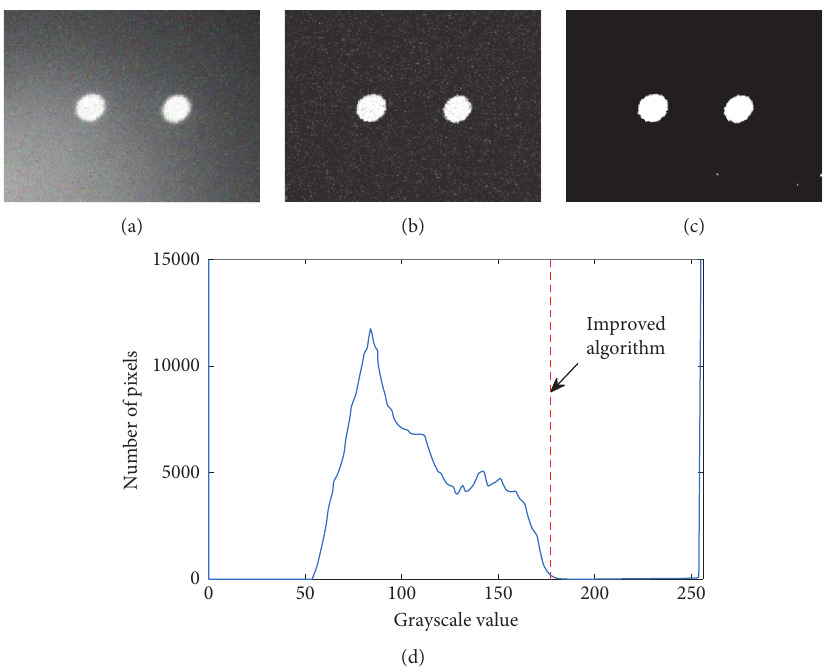
Figure 12: Laser speckle segmentation effect of intense light interference under pulse noise: (a) original image, (b) improved algorithm, (c) morphological processing, and (d) histogram and each segmentation